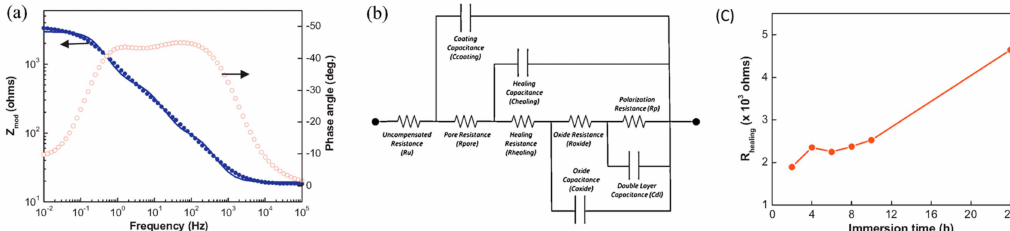
Figure 10. EIS Bode plots of epoxy coatings containing 20% microcapsule during immersion in 12 wt.% NaCl solution at di ff erent time intervals. Adapted from [14], with permission from © 2012 Elsevier.